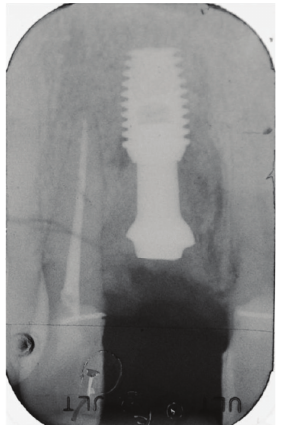
Figure 14: Bio-Oss (cid:3) was applied to cover the defect around the implant.